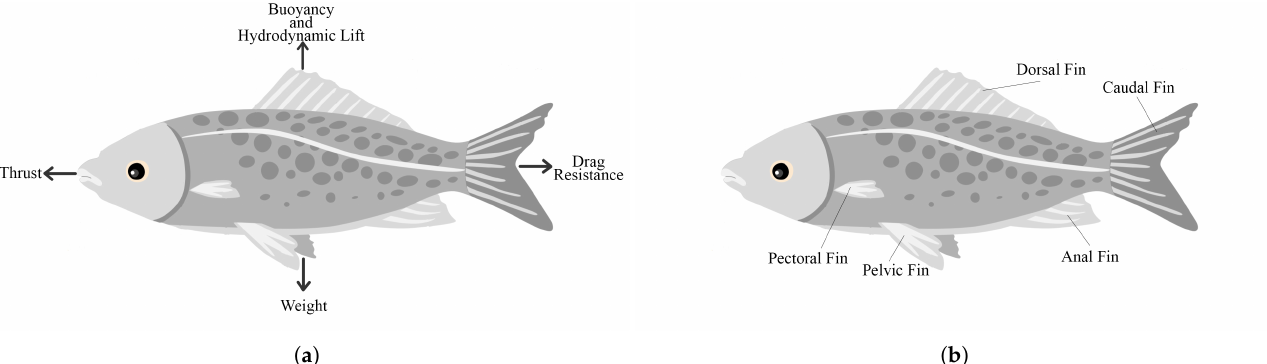
Figure 1. ( a ) The underwater forces acting on the fish during swimming. ( b ) Fish anatomy showing the different fins fish use to swim and